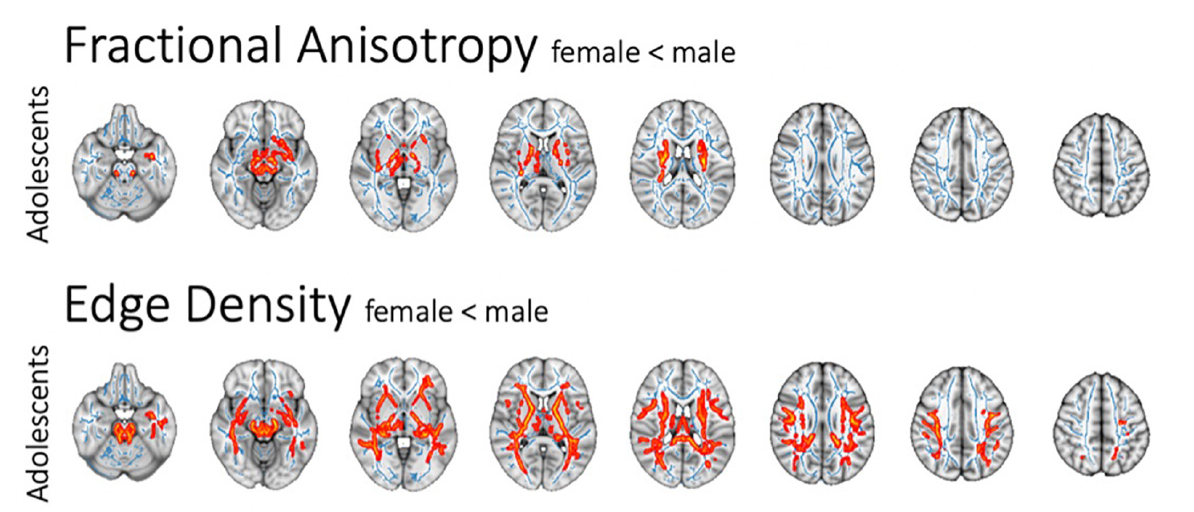
FIGURE4 Sex-related changes in FA and ED as assessed in voxel-wise analysis after correction for age and ASD diagnosis. The white matter tracts with significant difference are colored red ( p < 0.05) and overlaid on the mean FA skeleton